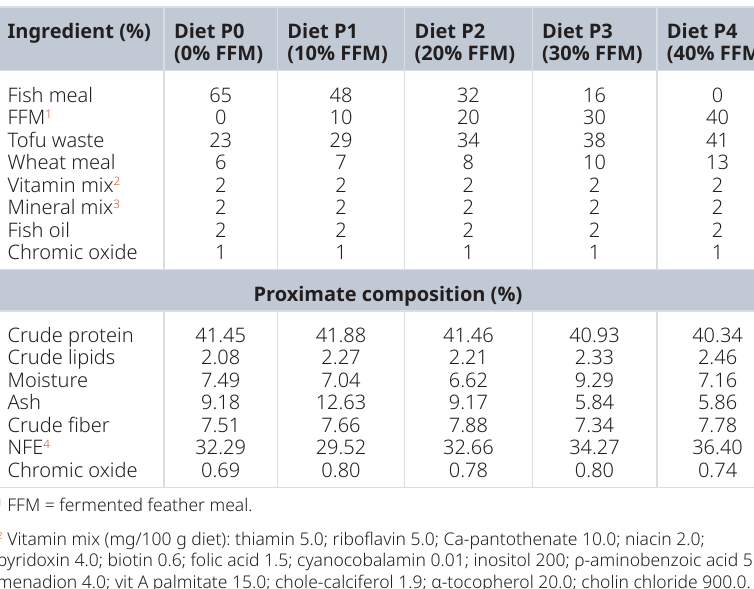
Table 1. Formulation and proximate composition of experimental